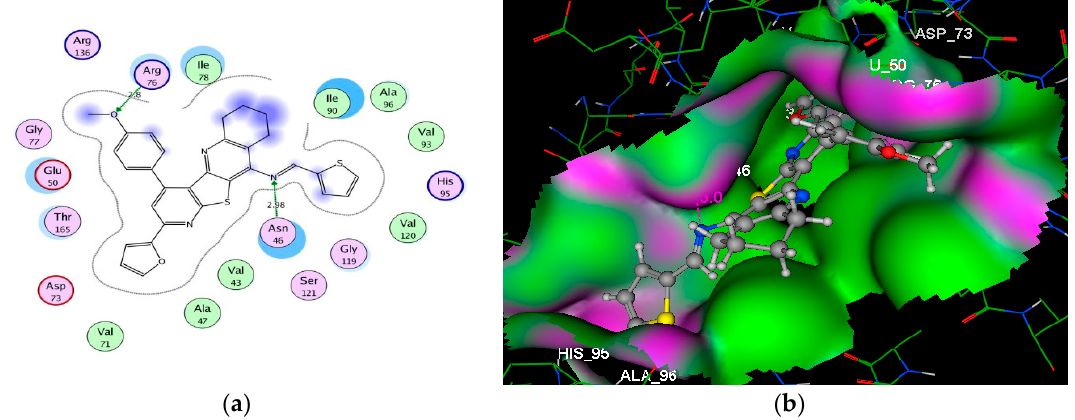
Figure 5. 2D ( a ) and 3D ( b ) diagrams illustrating the binding patterns of compound 9b into the ATP-active pocket of E. coli DNA gyrase B (PDB code: 1AJ6).